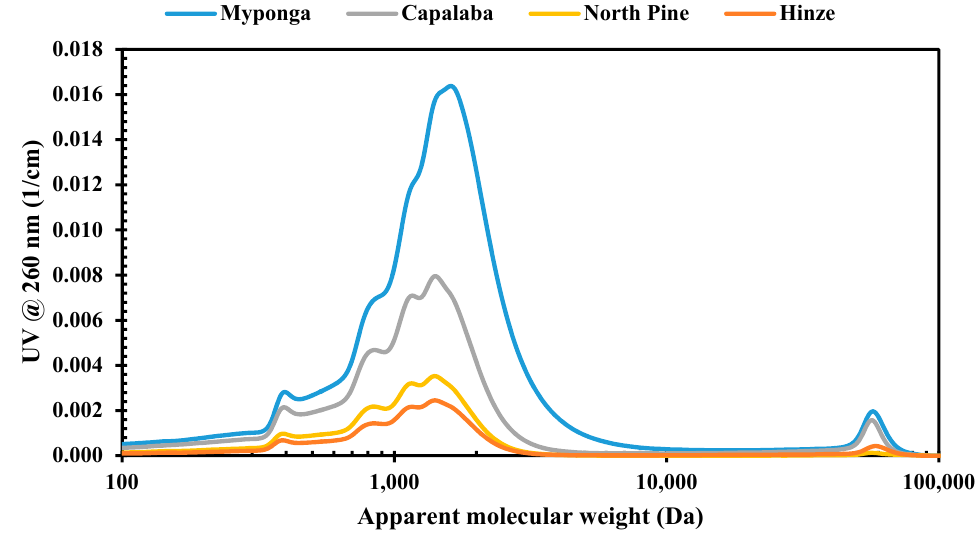
Figure 9. MW distributions by high pressure size exclusion chromatography (HPSEC)—Combined chromatographs.